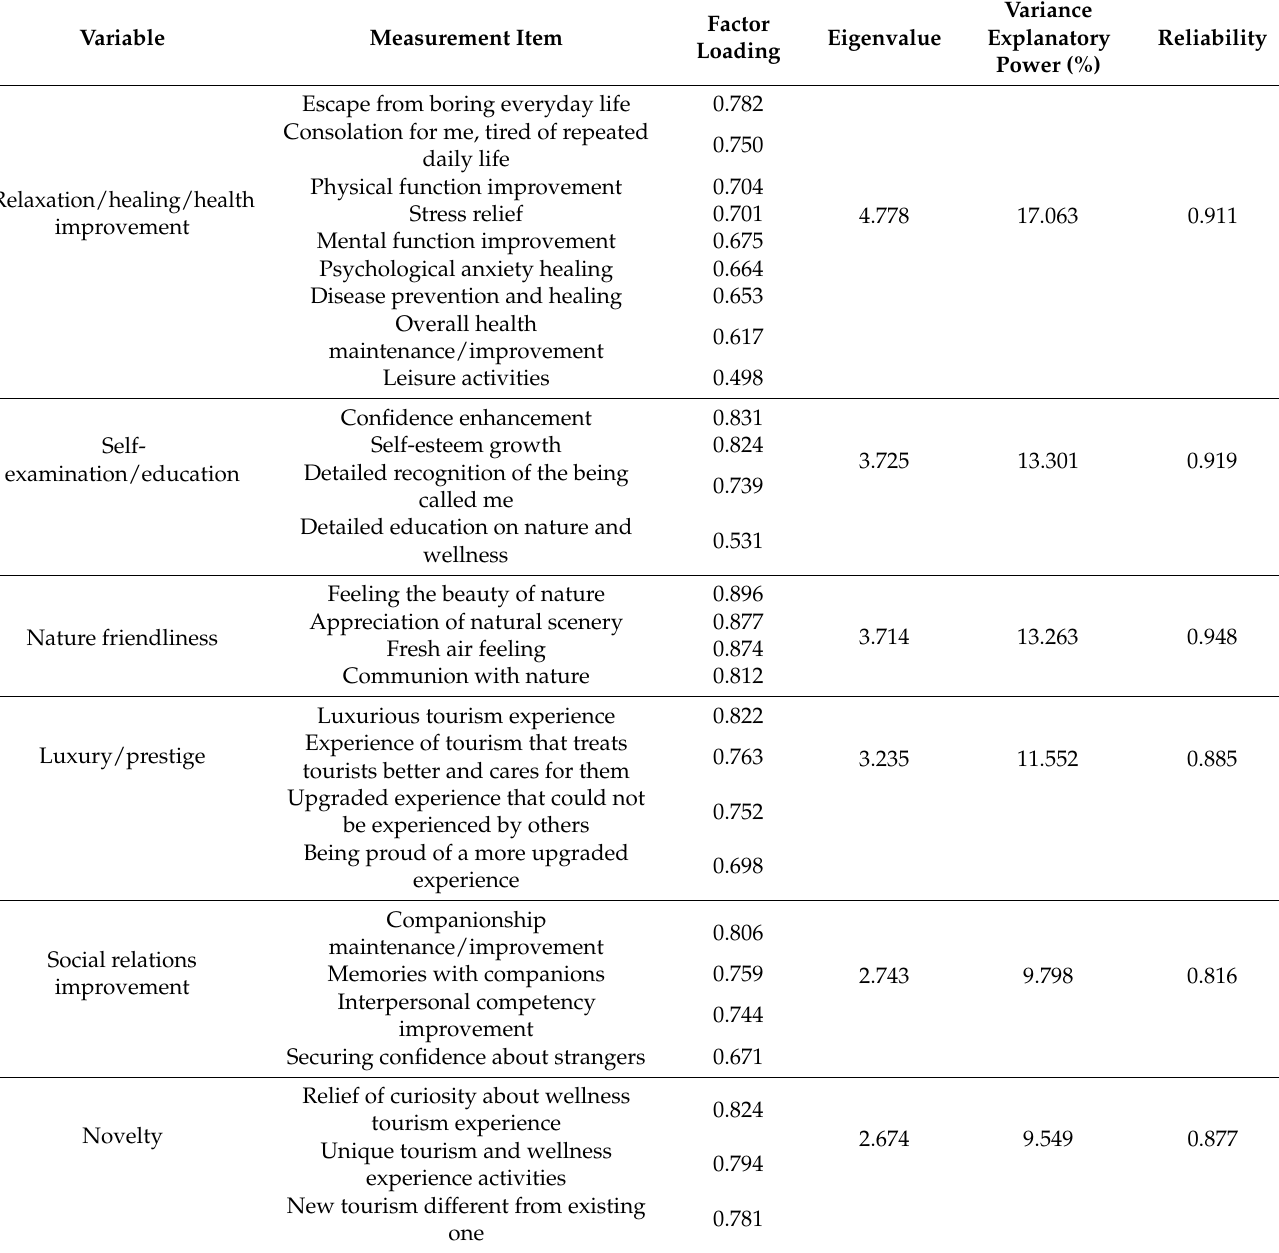
Table 6. Results of factor analysis of measurement items for motivations for participation in wellness tourism